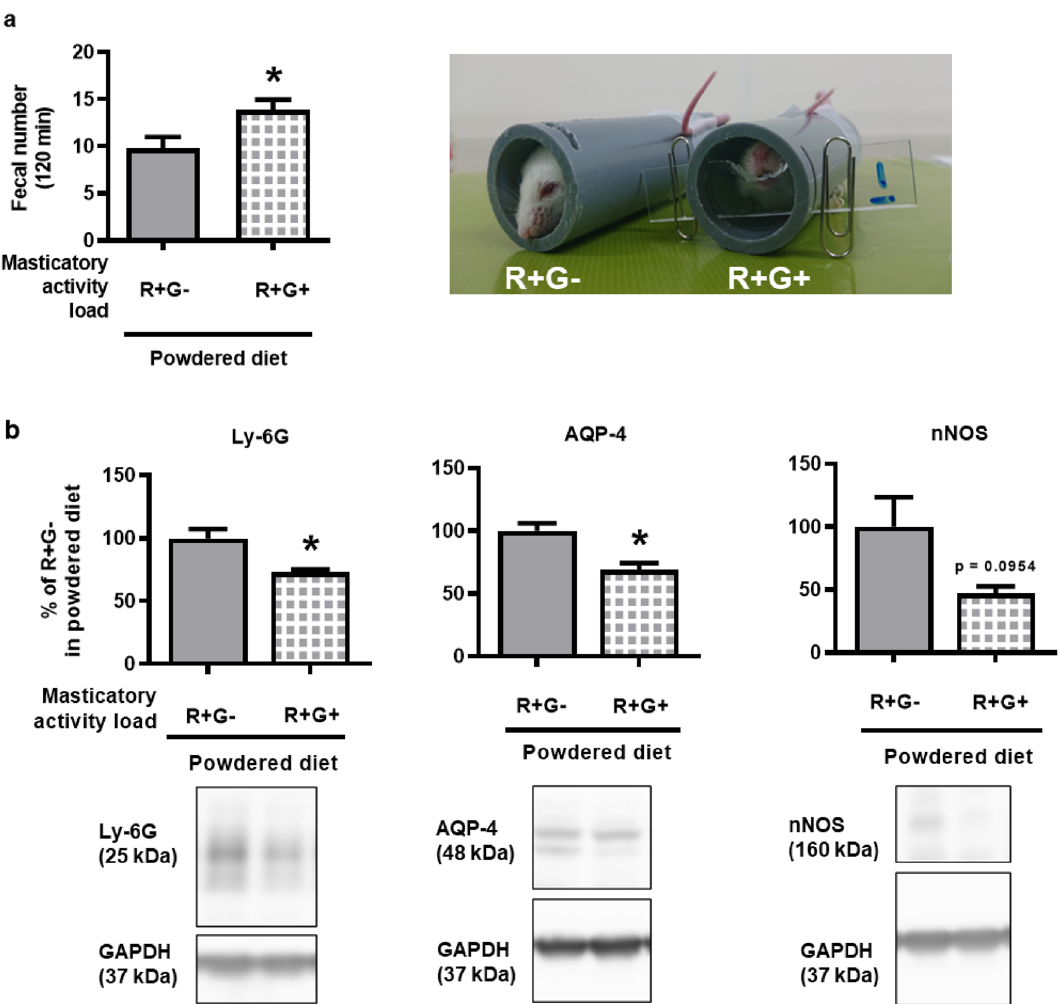
Figure 7. Effect of 2-h masticatory activity on the constipation-like symptoms of long-term powdered diet-fed mice. ( a ) Fecal pellet output (p = 0.0214, n = 13 per group) and ( b ) western blotting analysis of Ly-6G, aquaporin 4, and neural nitric oxide synthase (nNOS) expression (p = 0.0234, 0.0201, and 0.0954, respectively, n = 3 per group) in the colons of long-term powdered diet-fed mice subjected to the 2-h restraint-gnawing (R + G +) protocol. Full length blots are presented in Supplementary Fig. S7. The data are given as the mean ± SEM for a group. Student’s t -test was used to determine statistical significance. *p < 0.05; vs. R + G−